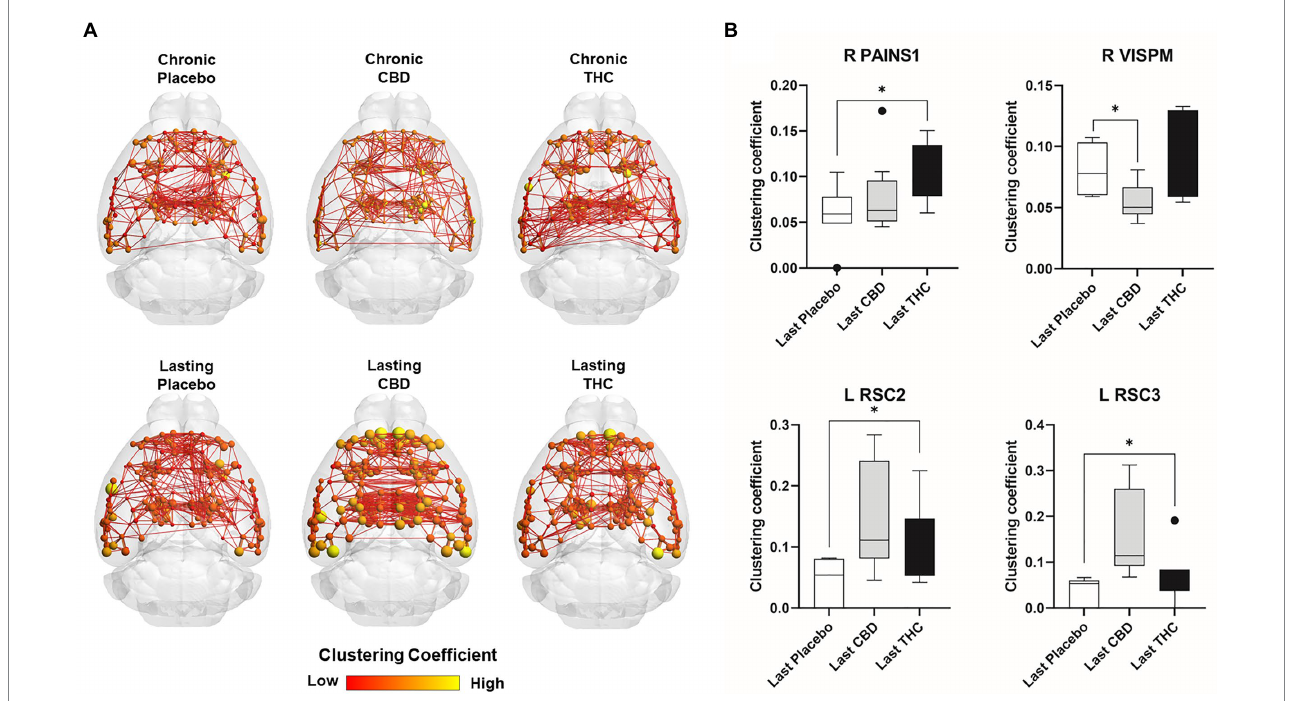
FIGURE 10 Regional differences in clustering. Regional differences in clustering coefficient following chronic placebo, CBD, or Δ 9-THC over 28 days (chronic) and after a 2-week washout period (lasting). (A) Connectome maps of a mouse functional network highlighting mean clustering coefficient across groups. Spheres represent scaled area under the curve (AUC) values for clustering coefficient calculated over several edge density thresholds (2–40%). Size and color intensity of spheres reflect high-to-low values (see scale bar). Lines between nodes represent pairwise connectivity between nodes (these are shown at edge density of 6% for visual clarity). (B) Clustering coefficient values for chronic treatment mice (calculated at a 16% edge density threshold). Clustering coefficient values for post-washout period (calculated at a 16% edge density threshold). Data are shown as mean ± standard error (two-way ANOVA with repeated measures, post-hoc t-tests with FDR q = 0.05, p < 0.05). Abbreviations: R PAINS1, right posterior agranular insula node 1; R VISPM, right posteromedial visual cortex; L RSC2/3, Left retrosplenial cortex nodes 2 and